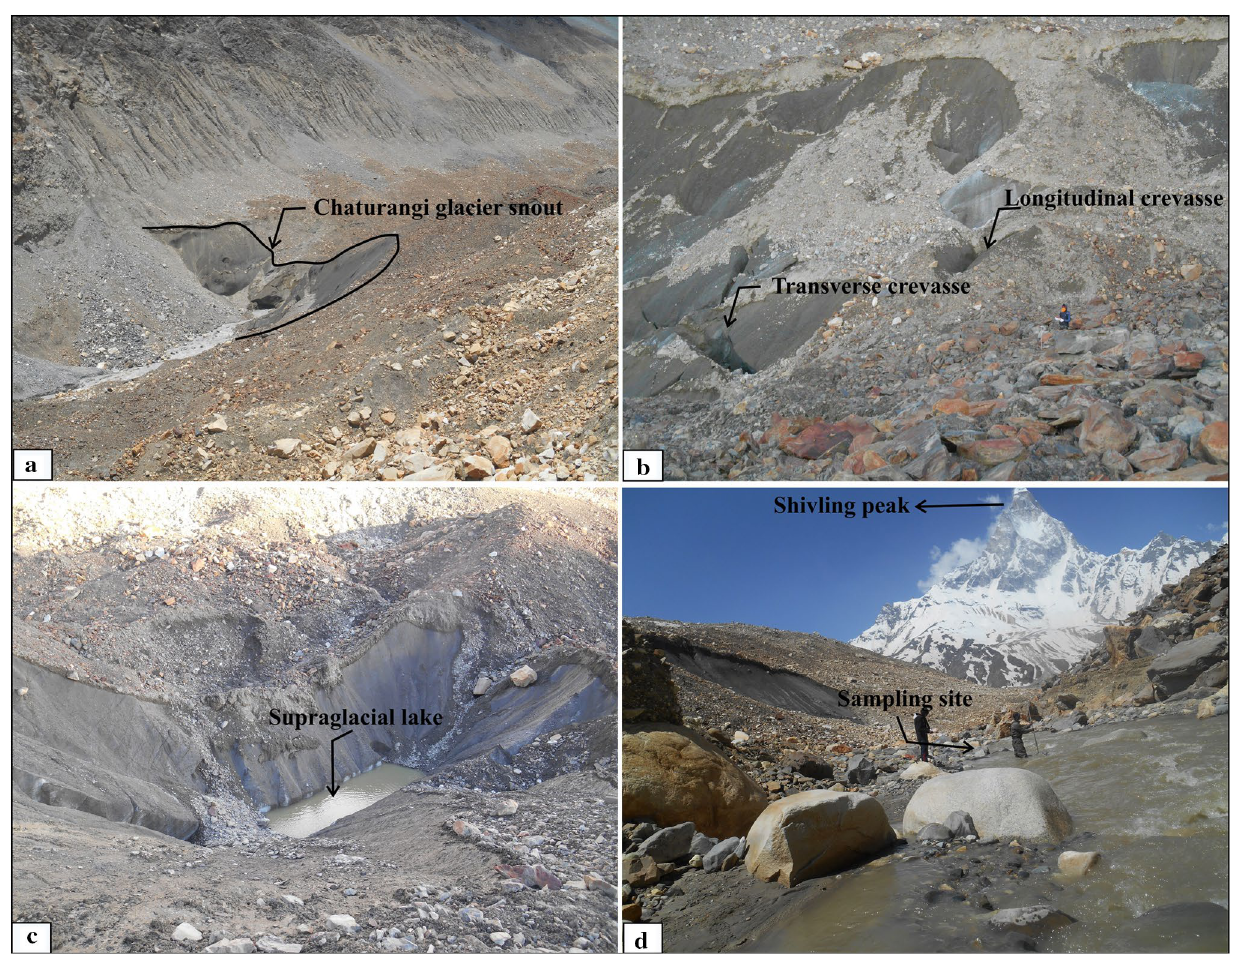
Fig. 2 Field photographs a Snout of the Chaturangi glacier from which Chaturangi river originates. b Transverse and longitudinal crevasses on the surface of glacier. c Supraglacial lake on top of the